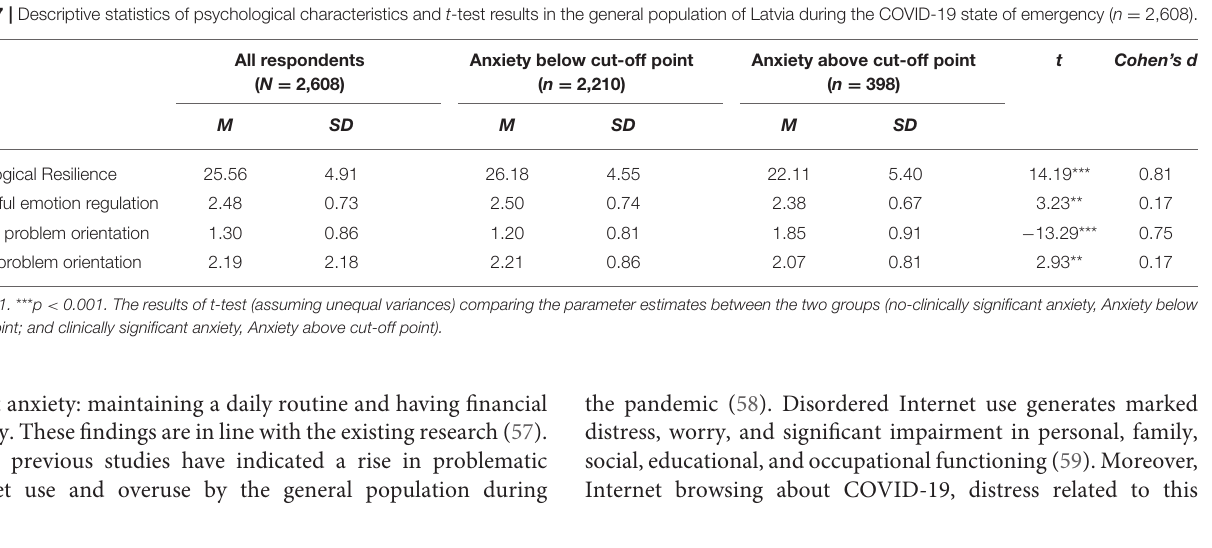
Anxiety below cut-off point Anxiety above cut-off point ( N = 2,608) ( n = 2,210) ( n =